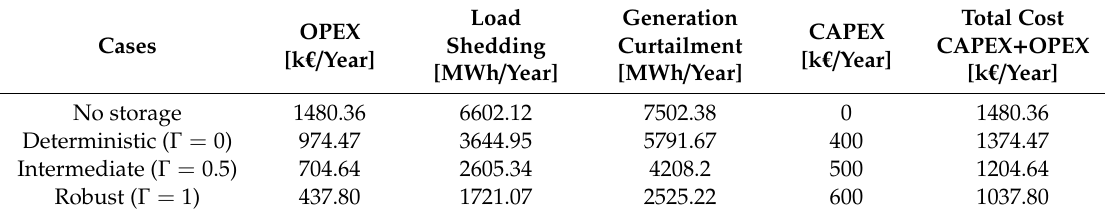
Table 2. Daily operational cost of the test network and ESS